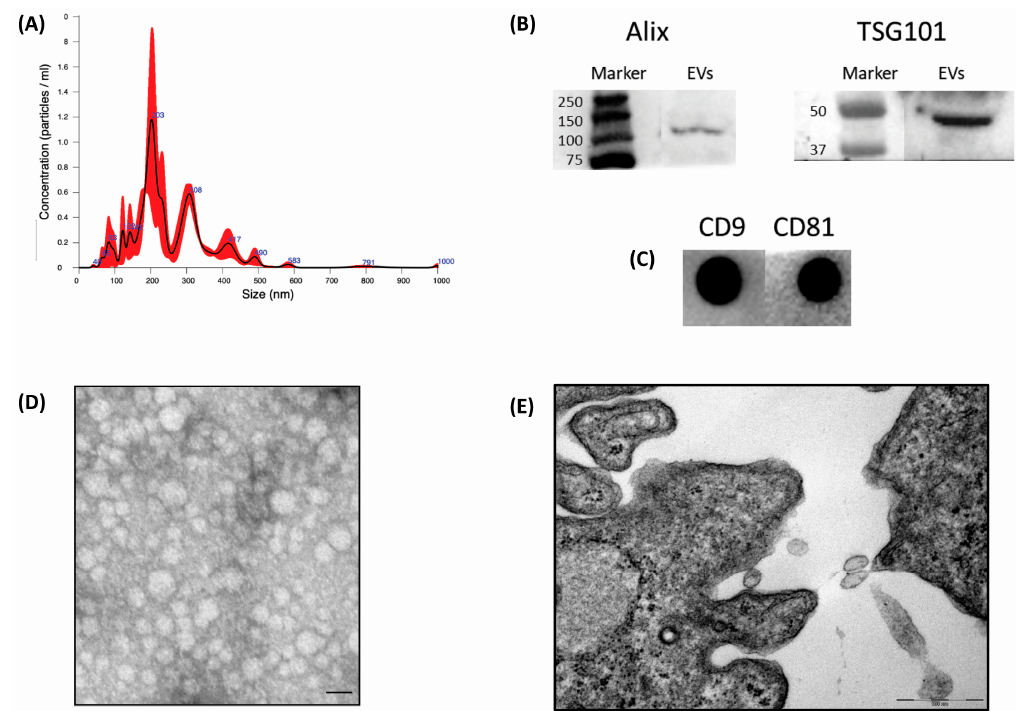
Figure 1. Characterization of amniotic EVs. ( A ) Results of the NanoSight analysis; ( B ) Western blot for internal EV marker and contaminant (Alix and TSG101); ( C ) dot blot for membrane markers (CD9 and CD81); ( D ) transmission electron microscopy analysis of EVs inside the seminal plasma showing typical morphological characteristics of vesicles (scale bar: 0.2 μ m); ( E ) the ultrastructural observation of a mesenchymal stromal amniotic cell, allowing us to highlight the presence of extracellular membranous vesicles with electron-lucent or slightly electron-dense content located near the cells of origin (scale bar 500 nm).